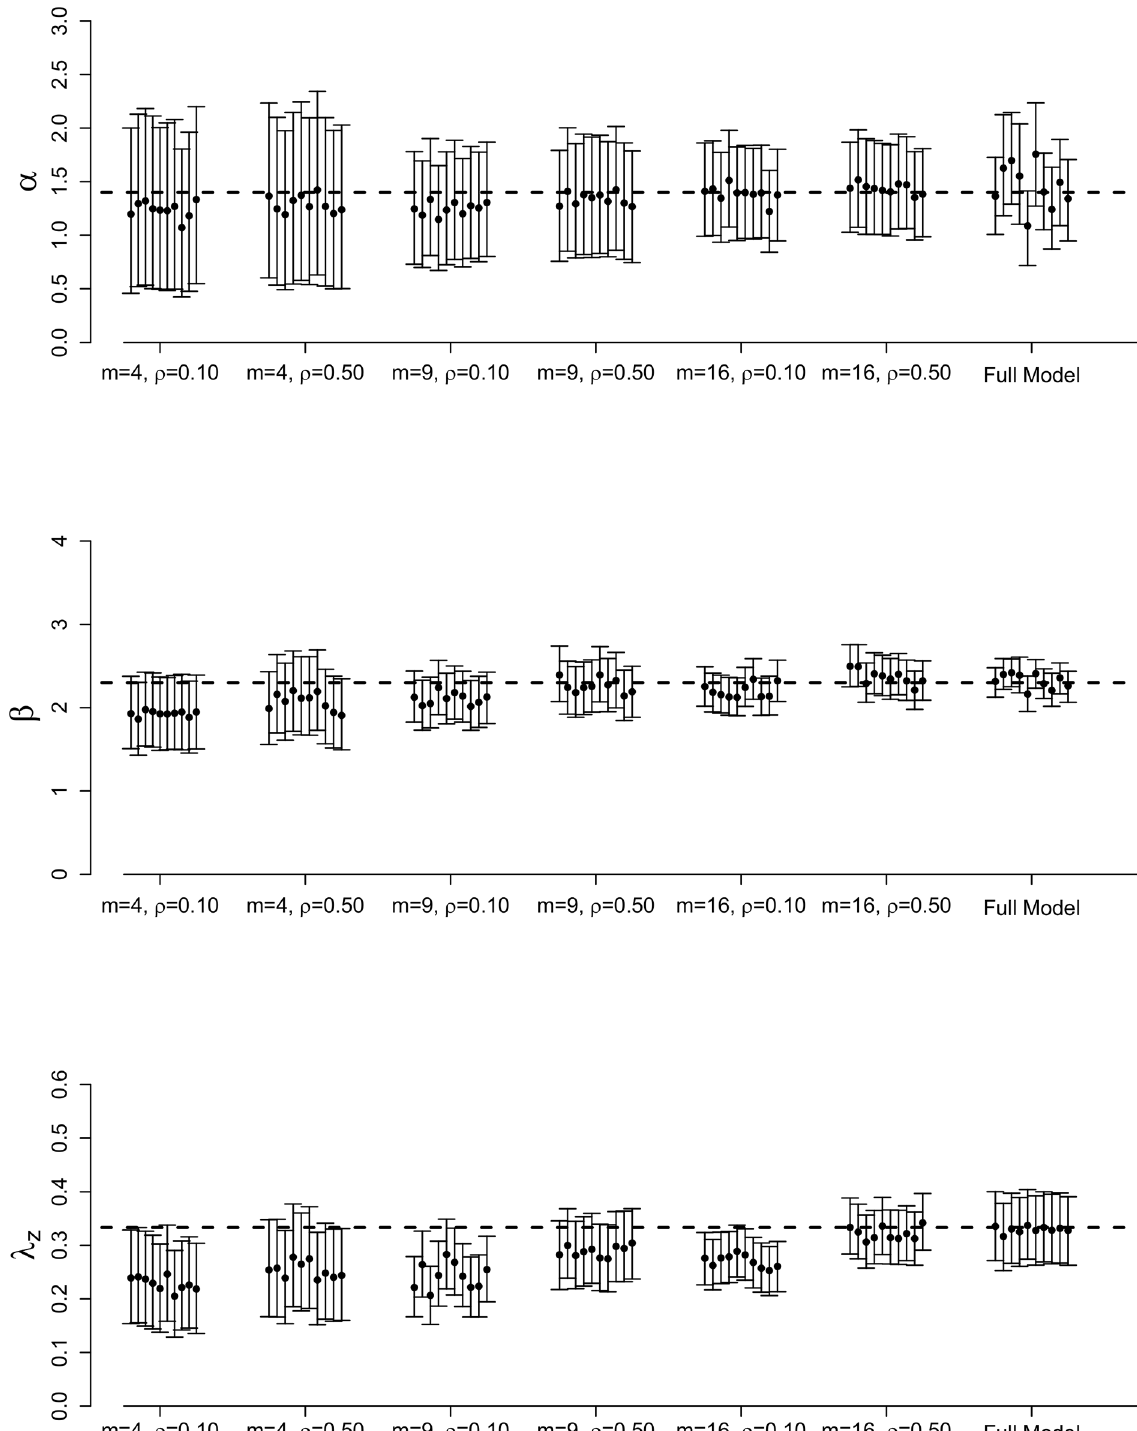
Fig 3. Full posterior results for full MCMC and spatial stratification methods. Posterior means and 95% credible intervals for α , β , and λ z for the full MCMC and spatial stratification methods for 10 different epidemics simulated from the data augmented spatial ILM with varying values for m and ρ . The dashed, horizontal lines represent the true parameter values: α = 1.4, β = 2.3, and l z ¼ 1